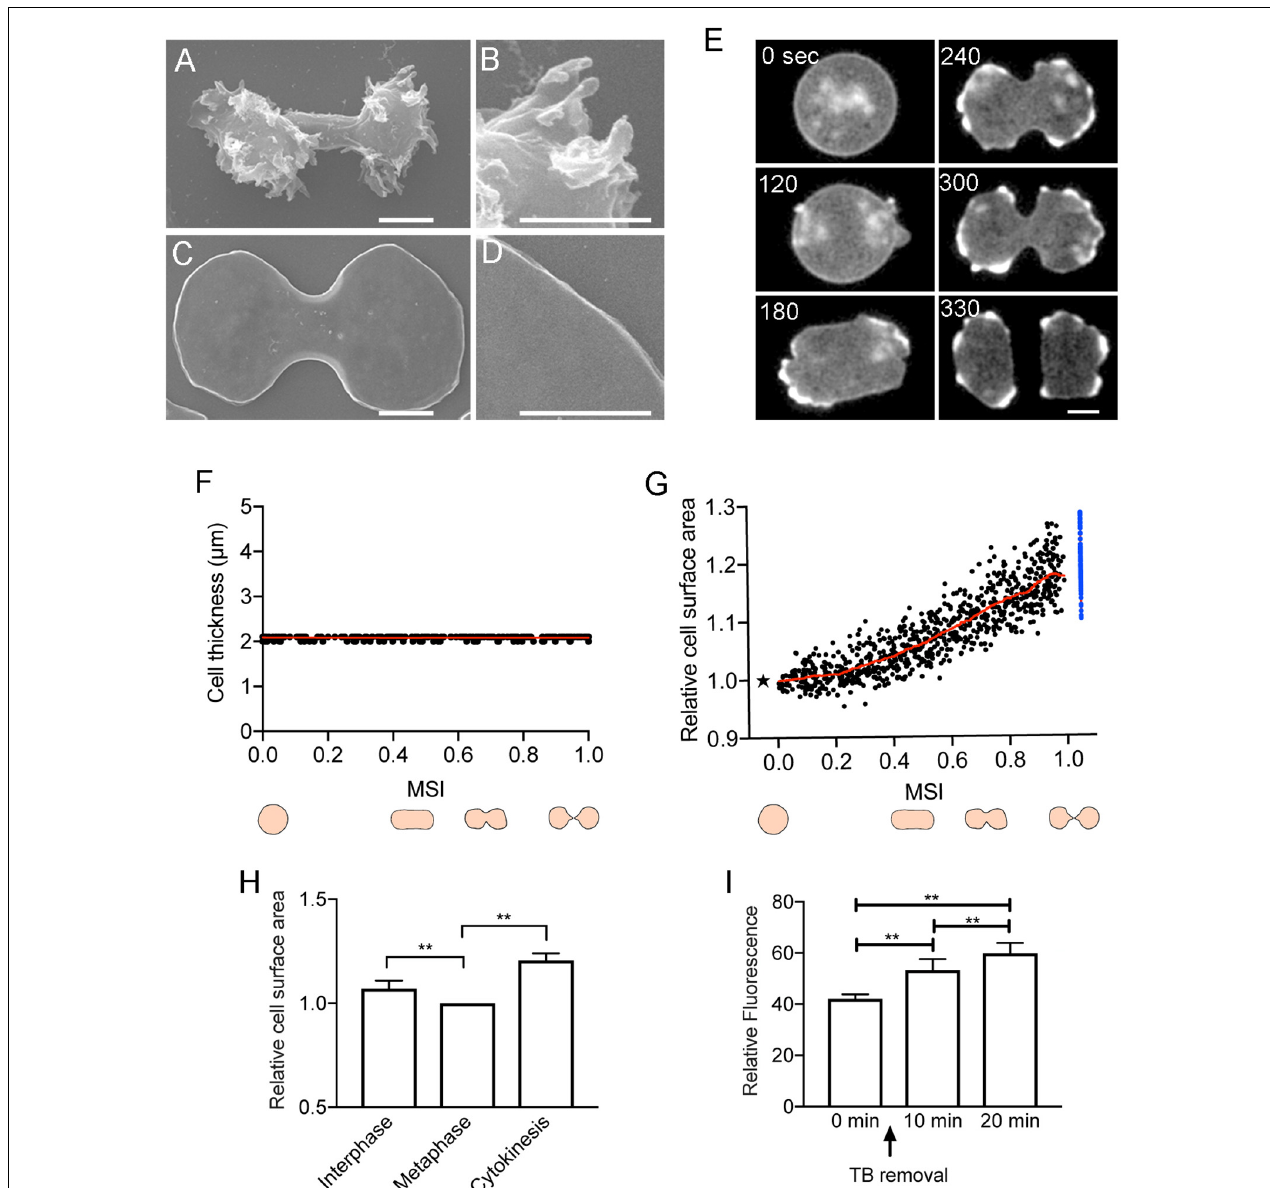
FIGURE 1 | Total cell surface area during cell division. Typical scanning electron micrographs of dividing Dictyostelium cells without (A,B) and with the agar overlay (C,D) . Fixed cells were observed after the agar sheet was removed. (B,D) Show enlarged images of (A,C) . Bars: 5 µ m. (E) Time course of cell division of a Dictyostelium cell expressing green fluorescent protein (GFP)- actin-binding domain of filamin (ABD). Bar: 10 µ m. (F) Time course of the thickness of the agar-overlaid cells during cell division, measured by sectioning microscopy ( n = 22). The cell division time was normalized according to the mitosis stage index (MSI). (G) Time course of the relative cell surface area during cytokinesis (versus MSI). The surface area is normalized to 1 at the metaphase (asterisk). The sum of the surface area of the two daughter cells is represented by blue dots. The red line shows the average. (H) Comparison of the relative surface area at the interphase, metaphase, and at end of cytokinesis. Data are presented as the mean ± SD and analyzed by one-way ANOVA with Tukey’s multiple comparisons test. ** P ≤ 0.001, n = 15. (I) Relative fluorescence intensities of FM1-43-stained cells measured by a fluorescence spectrophotometry. The fluorescence intensity of the stained cells is shown before thiabendazole (TB) removal (0 min) as well as 10 and 20 min after the initiation of cell division. Data are presented as the mean ± SD and analyzed by one-way ANOVA with Tukey’s multiple comparisons test. ** P ≤ 0.001, three different